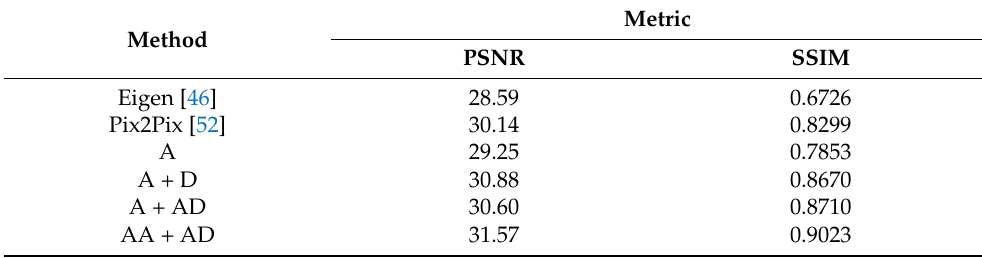
Table 2. Quantitative Evaluation Results of System Proposed by Qian et al. [49] Against other